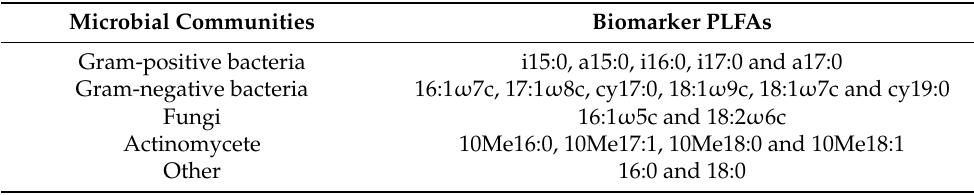
Table 2. The nomenclature of the phospholipid fatty acids (PLFAs) in this study. Microbial